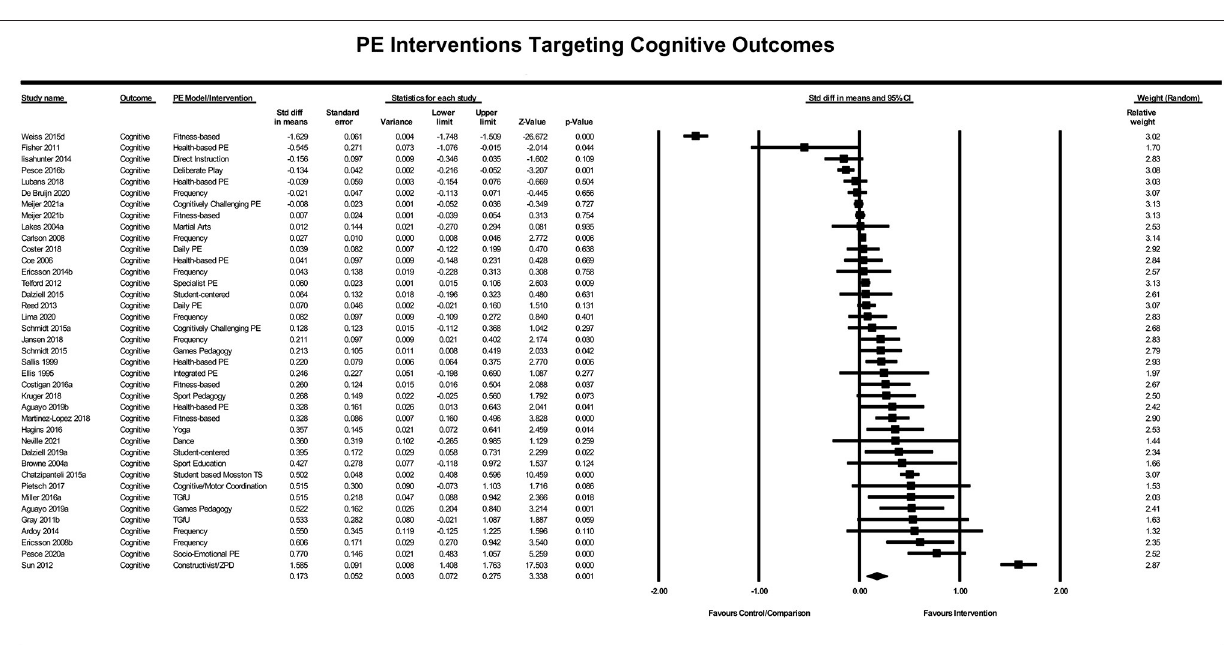
FIGURE 3 | Forrest plot of standardized difference in means of cognitive PE